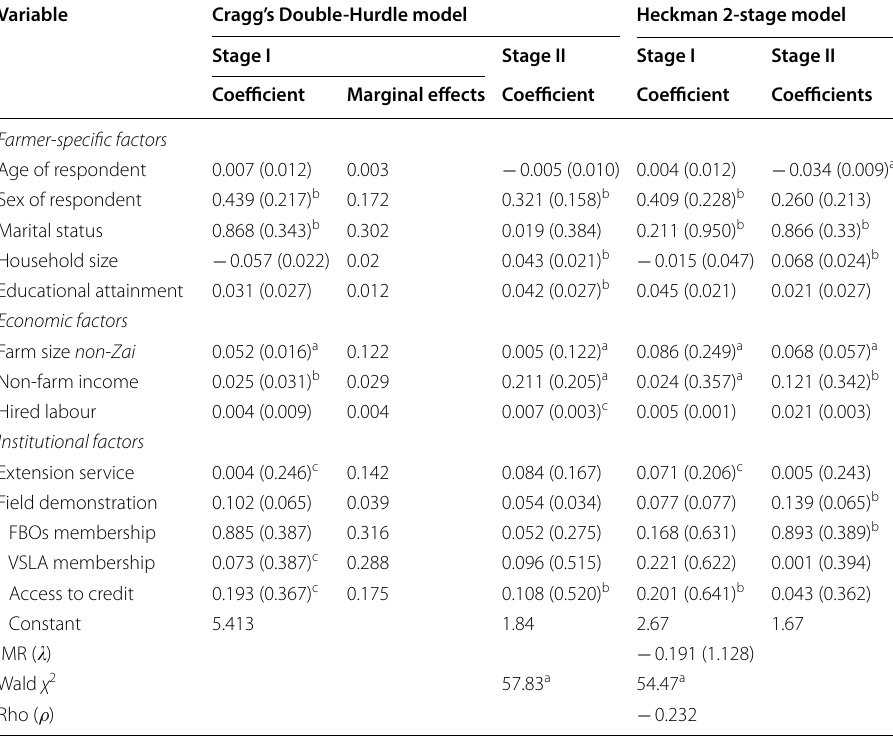
a, b and c represents 1%, 5% and 10% significance levels, respectively. The figures in the brackets are the standard errors